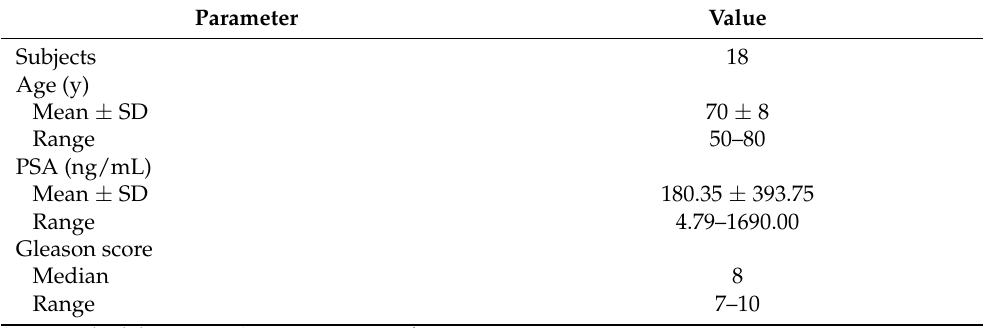
Table 1. Characteristics of the study